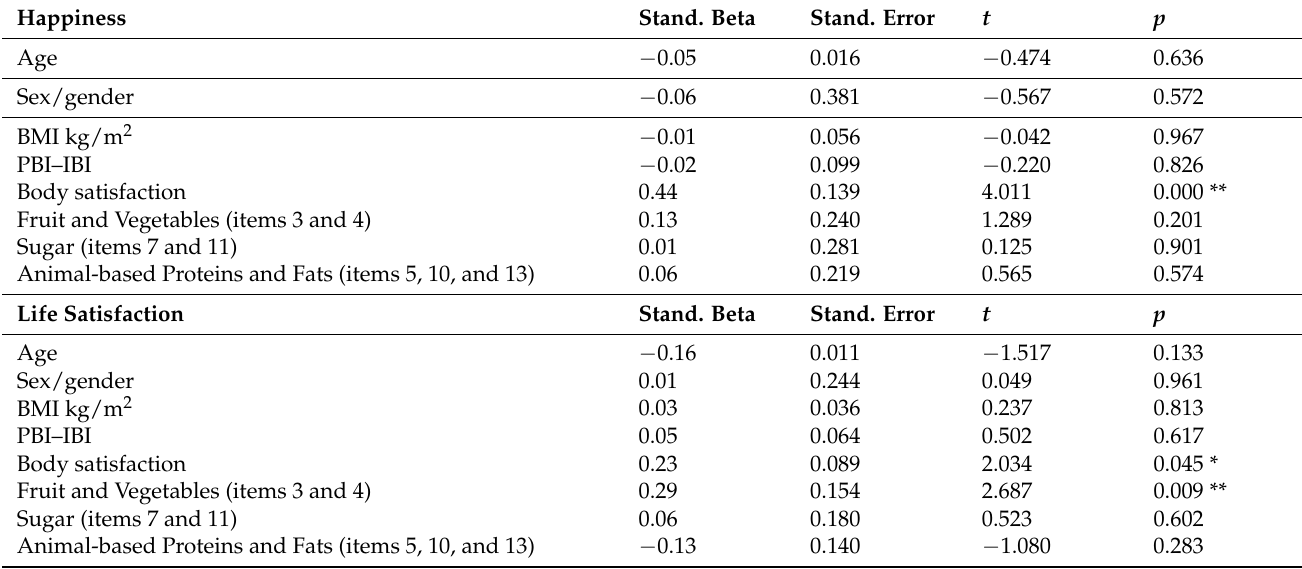
Table 4. Hierarchical multiple regressions of happiness (up) and life satisfaction (down) on sociodemographic, weight status, body perception and satisfaction, and MedDiet indicators (final model). Stand.